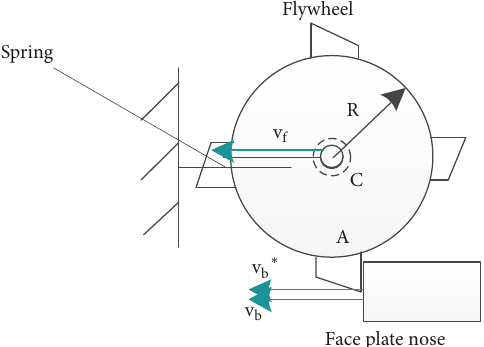
Figure 2: Illustration of angular momentum conservation of system consisting of the face plate and flywheel (take one flywheel to